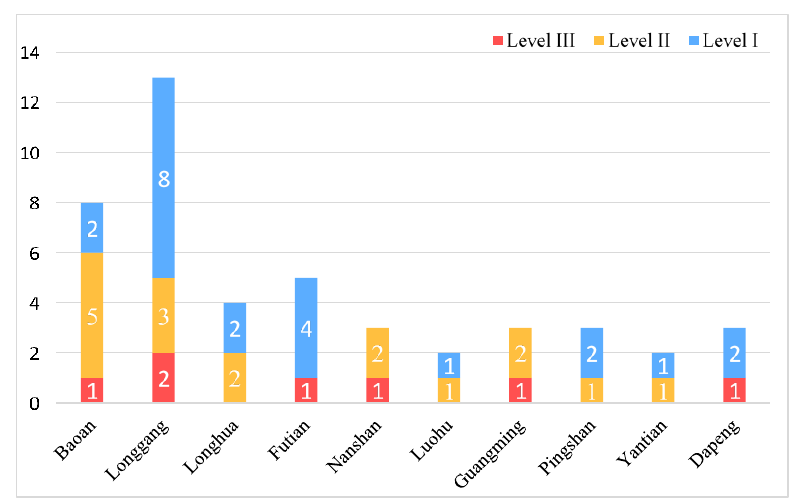
Figure 7. The numbers of low-level trauma centers that each administrative region should have.